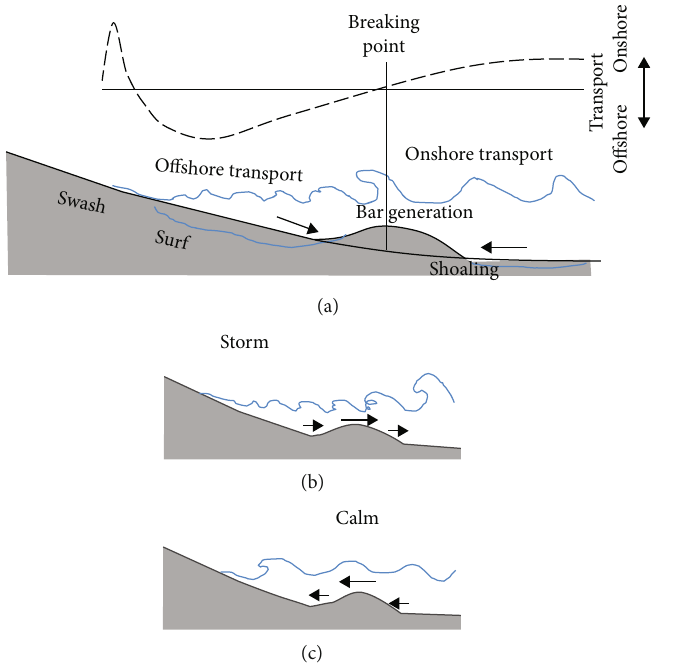
Figure 8: Schematic of nearshore transport. Shape function of velocity moments of the equation for time-averaged sediment